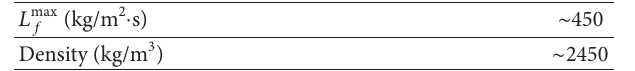
Table 2: Some properties of the selected catalyst